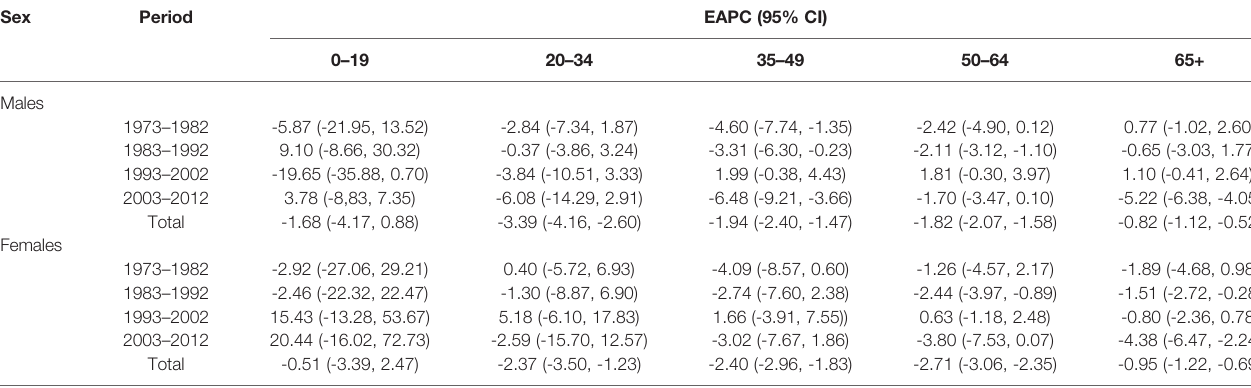
TABLE 4B | The estimated annual percentage changes (EAPC) of liver cancer incidence in Shanghai from 1973 to 2012.